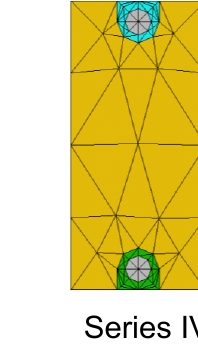
Figure 4. Mesh patterns of cross sections for composite beams in series